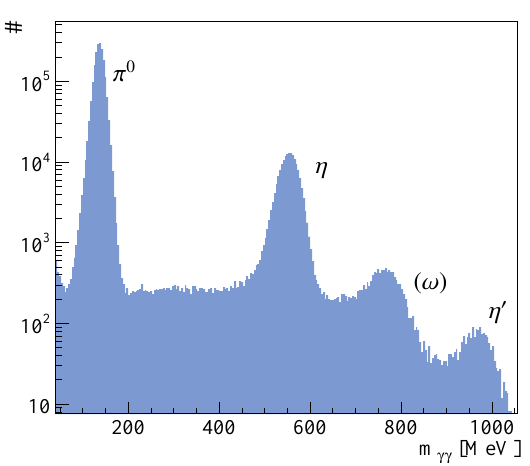
Figure 2. A typical two photon invariant mass is plotted. Clear peaks are visible for the π 0 , η , ( ω ) and η (cid:3) mesons. The back- ground is very low for the p π 0 and p η final states. The peak of the ω meson appears here due to a lost photon since it can decay to ω → π 0 γ